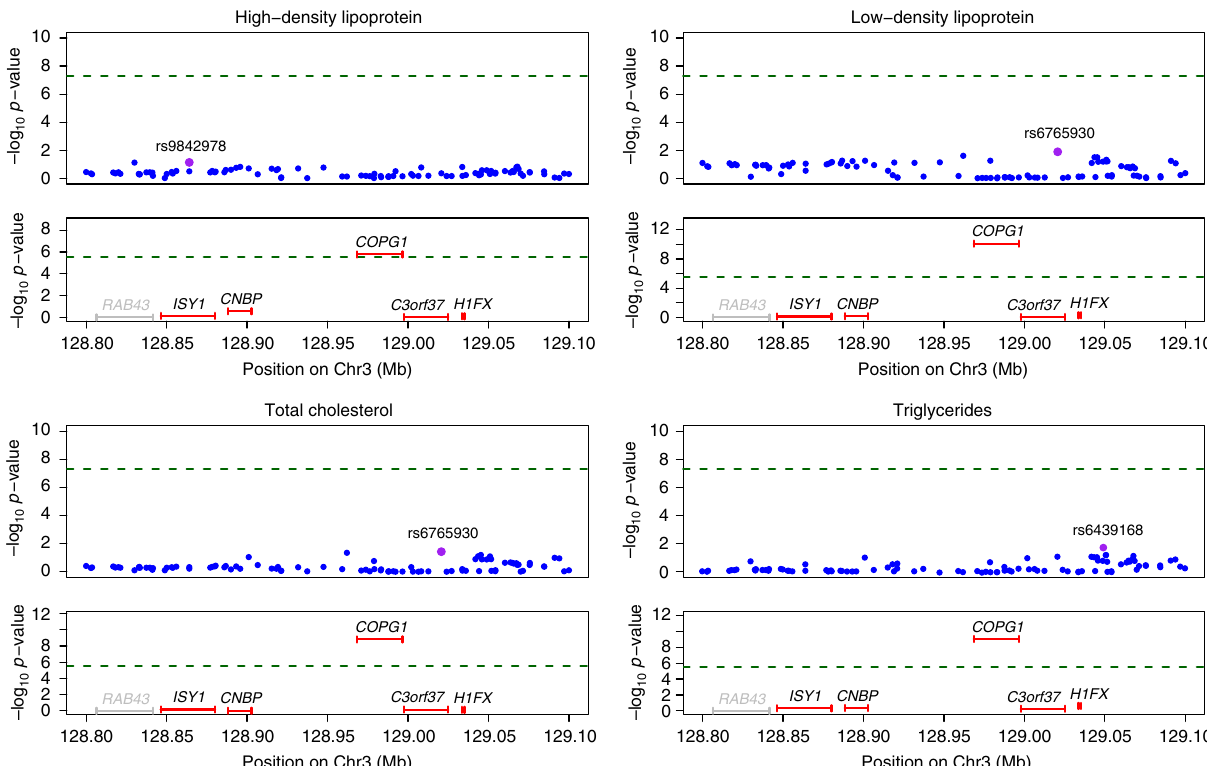
Fig. 3 Signi fi cant association between COPG1 and lipids traits. Regional association plot for GWAS and TWMR analyses for COPG1 locus associated with high-density lipoprotein (HDL), low-density lipoprotein (LDL), total cholesterol (TC), and triglycerides (TG). Top panels show single-SNP association strengths ( y axis shows the − log 10 ( p value)) versus genomic position (on hg19/GRCh37 genomic build; x axis) around the most signi fi cant SNP, indicated with a purple dot. Lower panels illustrate gene causal association strengths ( y axis shows the − log 10 ( p value)) versus genomic position. Genes highlighted in gray were not tested (i.e., they do not pass the heterogeneity test or not have signi fi cant eQTLs). Green dotted lines represent GWAS and TWMR signi fi cance